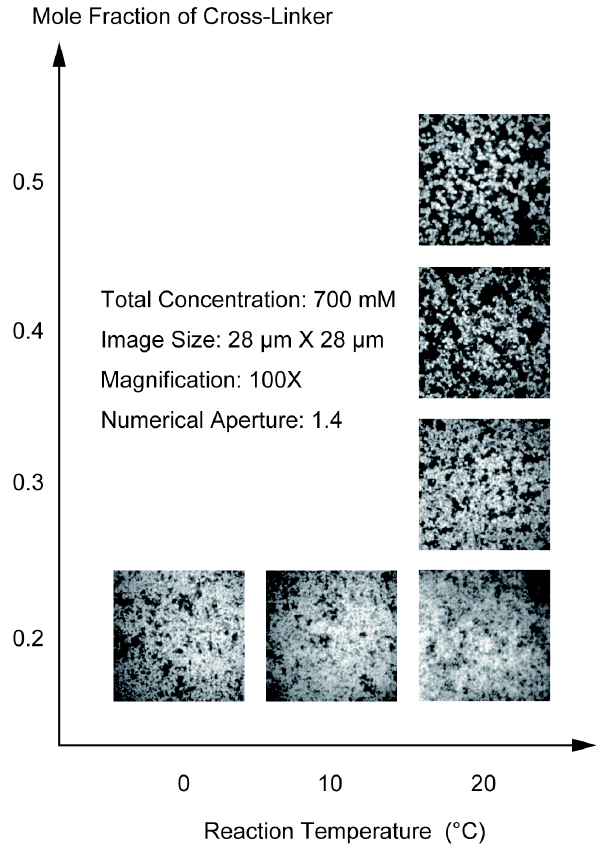
Figure 5. The confocal laser scanning microscope (CLSM) images of the opaque gels. The objective lens used here is 100× and the numerical aperture is 1.4. One side of the image corresponds to 28 µm. In the right column, the images of the gel gained by changing the mole fraction of the cross-linker are shown. In the bottom, the reaction temperature dependence of the image is shown. The total concentration of the gel is 700